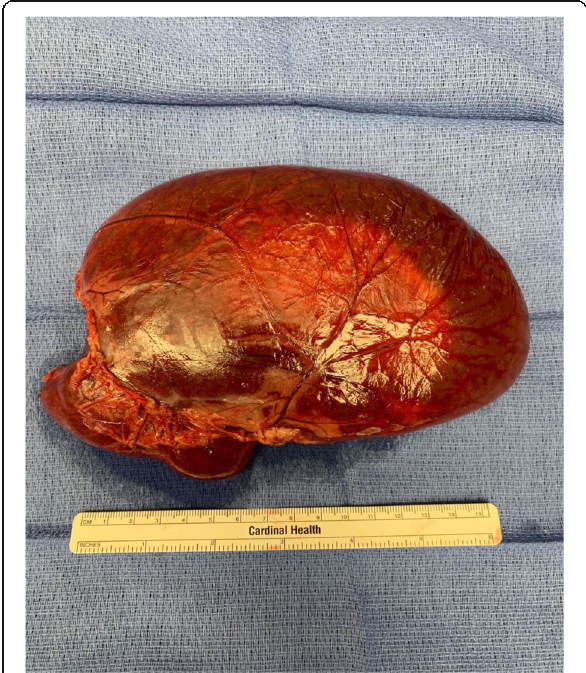
Fig. 3 After careful separation from the tail of the pancreas, the cyst was removed intact and sent to